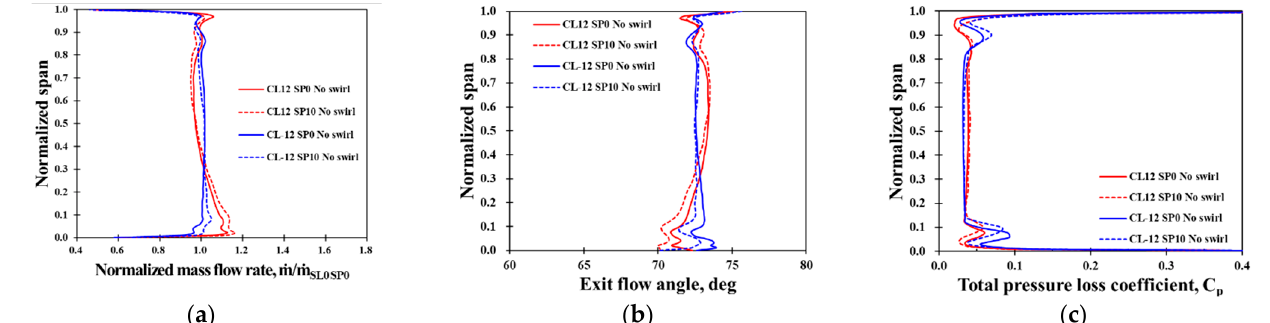
Figure 18. Comparison of circumferentially averaged mass flow rate ( a ), exit flow angle ( b ), and total pressure loss coefficient ( c ) due to the compound lean with sweep.